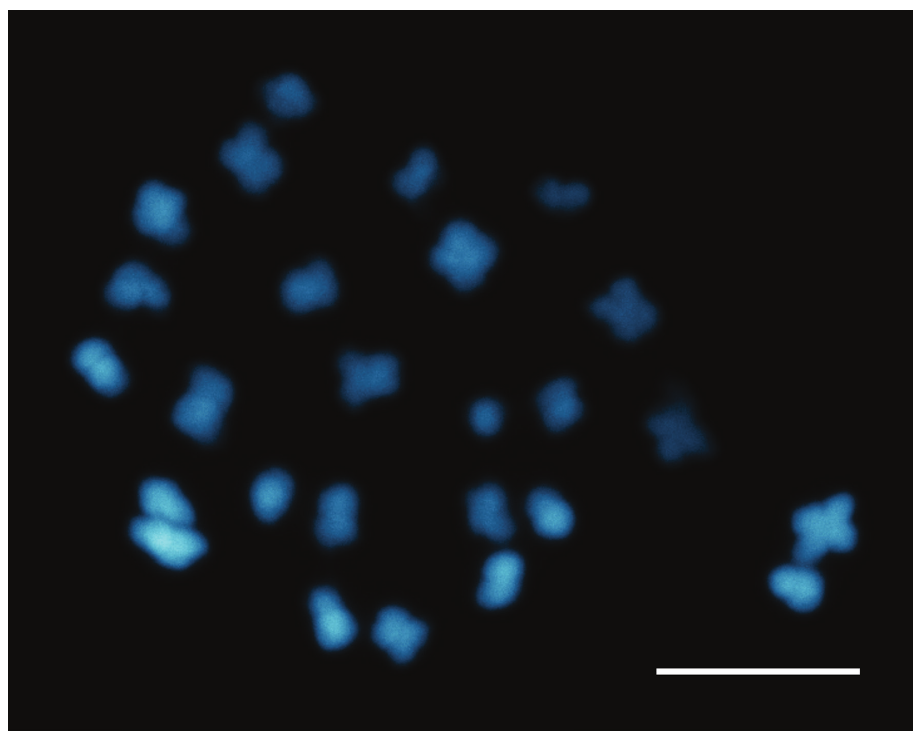
Figure 5. Mitotic metaphase chromosomes of Capsicum regale Barboza & Bohs, 2n = 26. Scale bar: 10